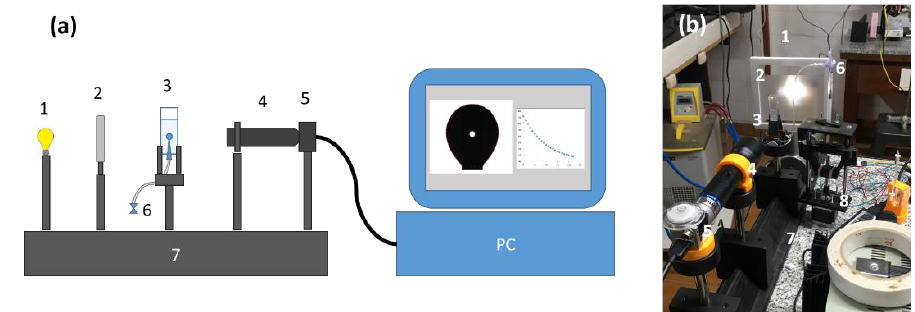
Figure 1. Pendent drop/sessile bubble setup. ( a ) scheme of the device; ( b ) photo of the same device. ( 1 ) light source ( 2 ) light diffuser ( 3 ) measurement cell ( 4 ) telecentric lens ( 5 ) CCD camera ( 6 ) valve ( 7 ) optical bench. ( 8 ) Syringe pump automatized system.